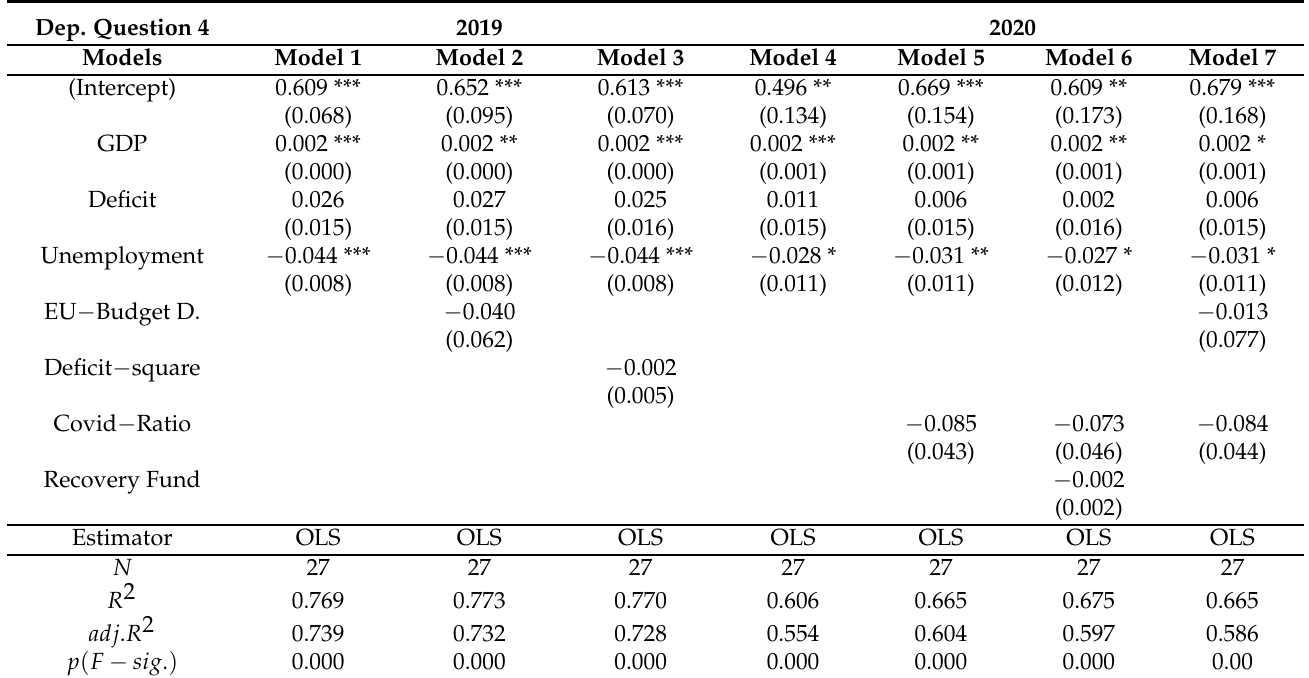
Table 2. Regression Table of Basic Models with 2019 and 2020